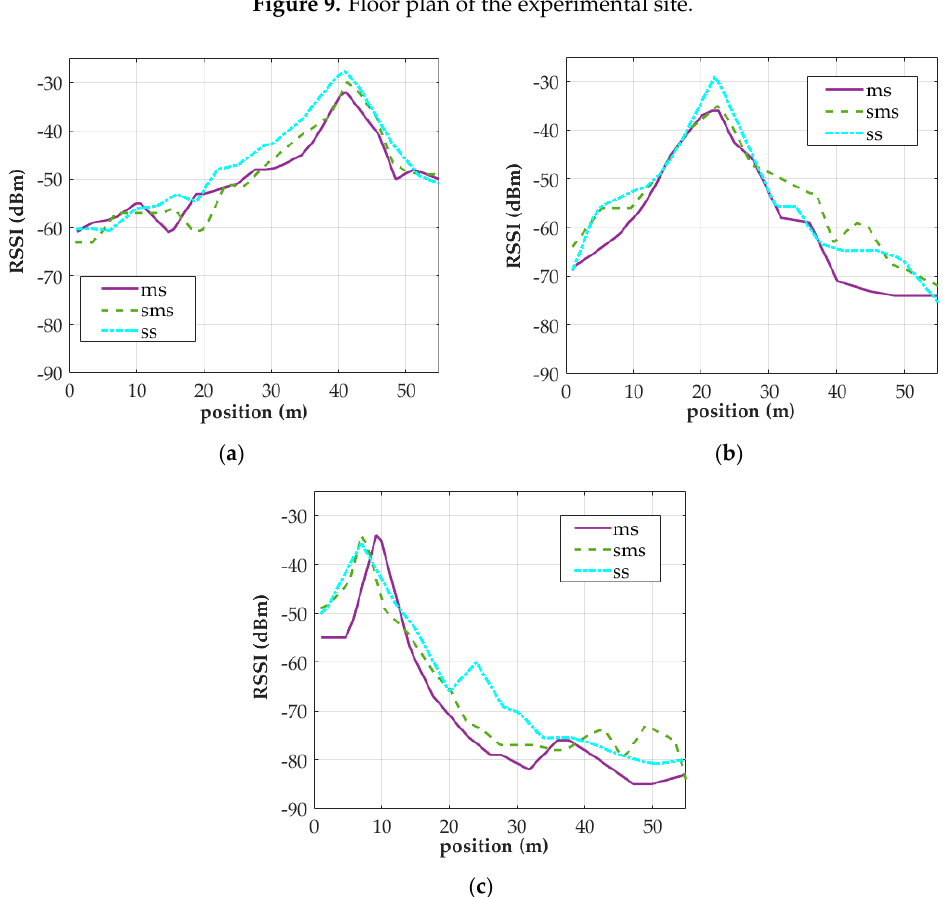
Figure 10. RSSI distributions of signals collected from various APs (the distributions were derived through the neighboring vertices averaging (NVA) algorithm): ( a ) AP1; ( b ) AP2; ( c )